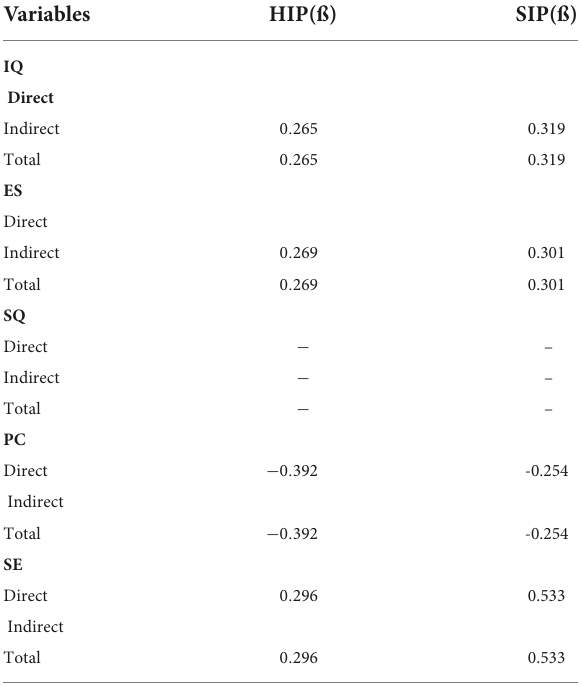
TABLE 7 Total, direct, and indirect effects of the model